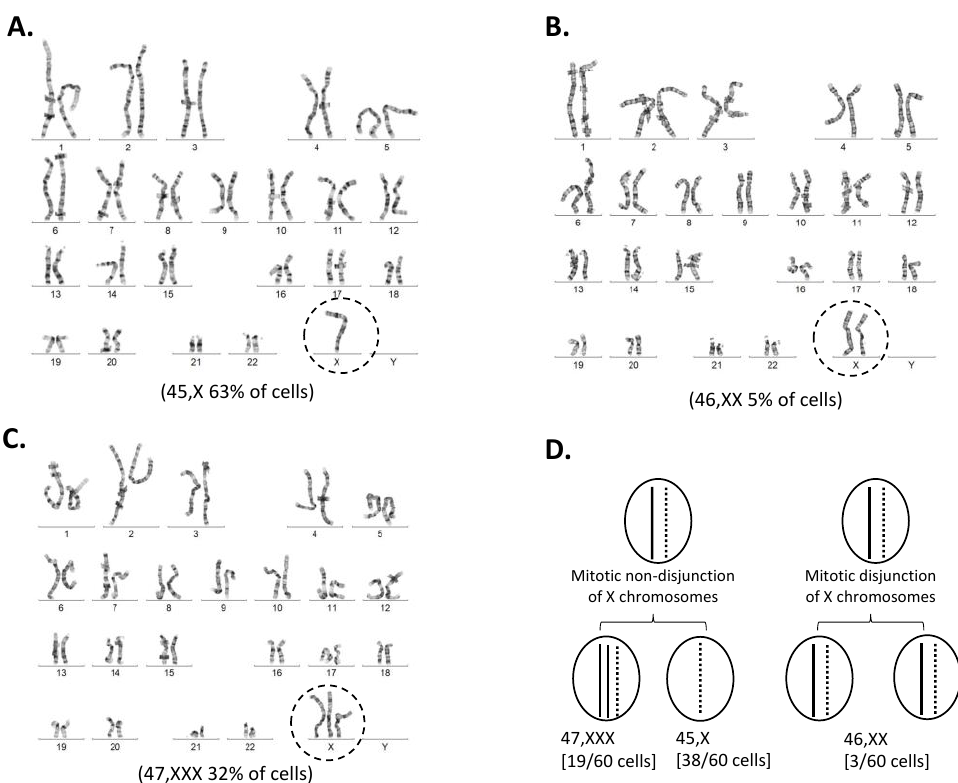
Figure 3. G banded chromosome analysis of II:2 proband blood and conventional karyotypes identify mosaic cell lines. ( A ) 45,X0 was found in 38/60 karyotypes analysed; ( B ) 47,XXX was found in 19/60 karyotypes analysed; ( C ) 46,XX was found in 3/60 karyotypes analysed. ( D ) Diagram of post zygotic nondisjunction and generation of the mosaic cell line 45,X[38]/47,XXX[19]1/46,XX[3]3.